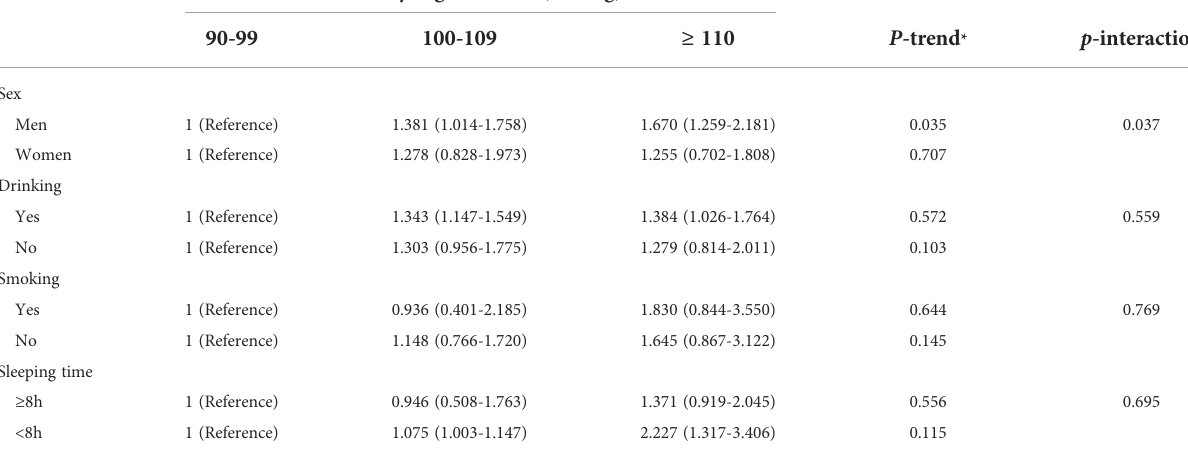
TABLE 4 Subgroup analysis of the risk of history highest DBP (mmHg) to